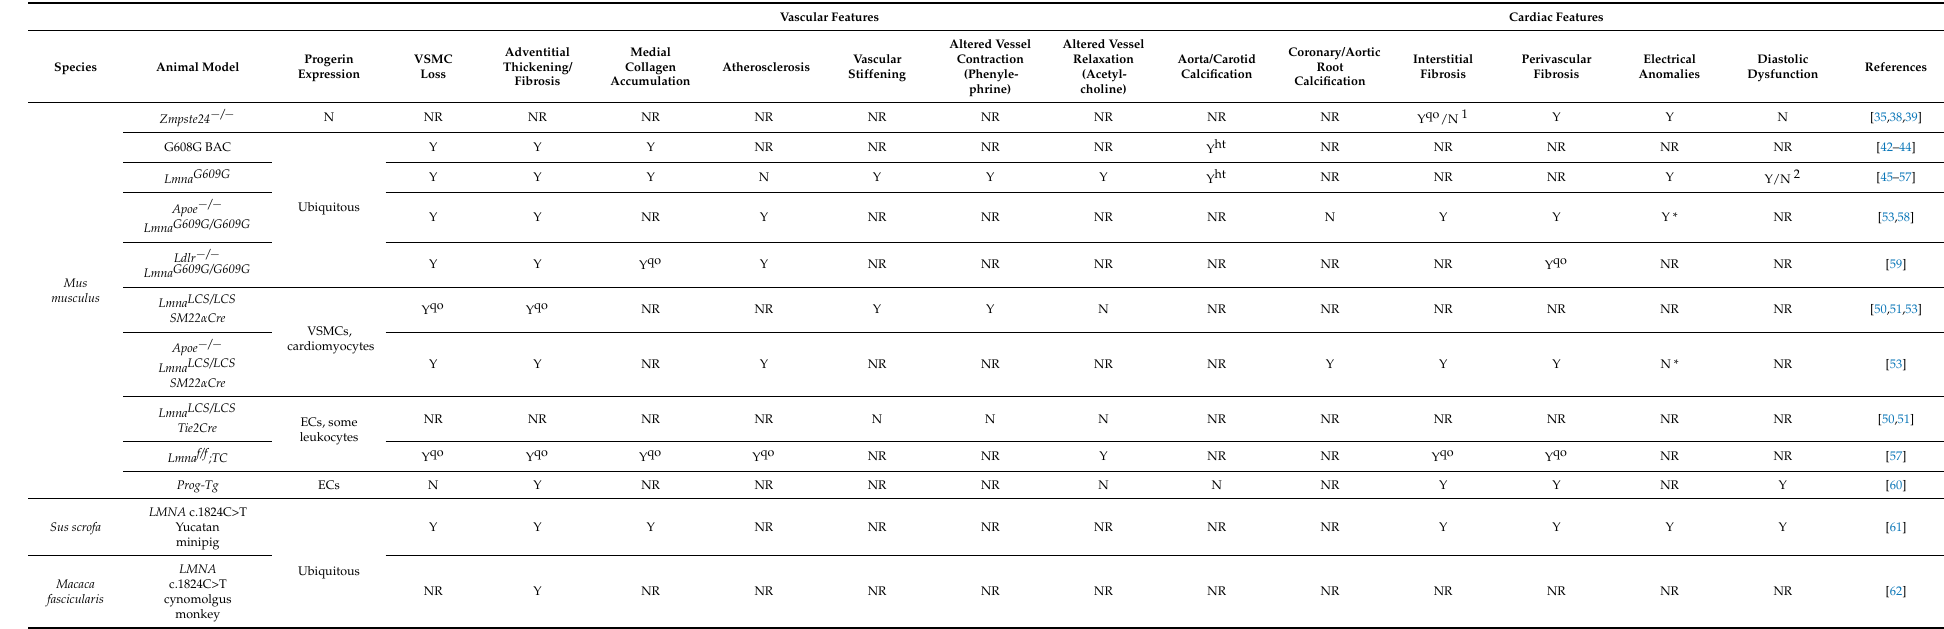
Table 1. Cardiovascular phenotype of HGPS animal